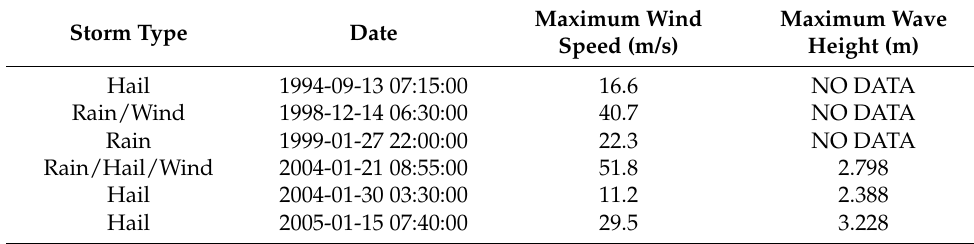
Table 3. Storm events under the “BATEMANS BAY” locational